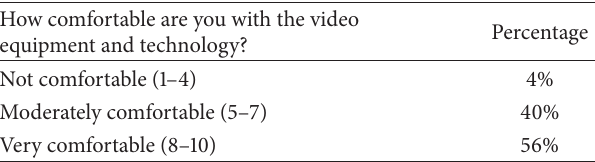
Table 3: Comfort with video equipment and technology ( 𝑛 = 25